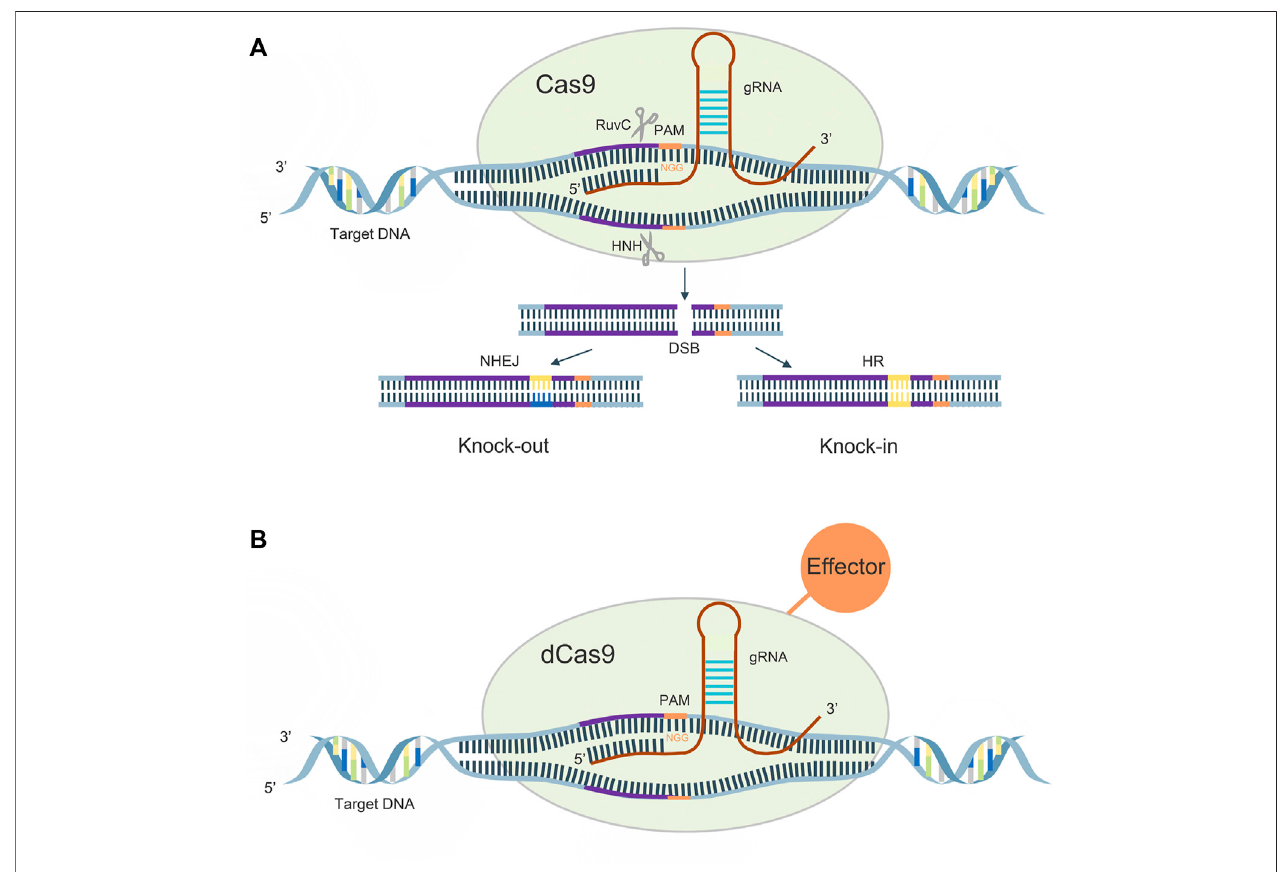
FIGURE 1 | (A) : Mechanism of CRISPR/Cas9 system; (B) : Mechanism of CRISPR/dCas9